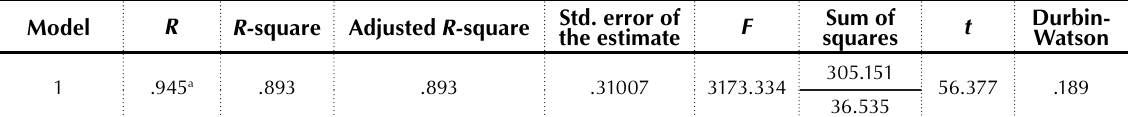
Table 2. Model summary b